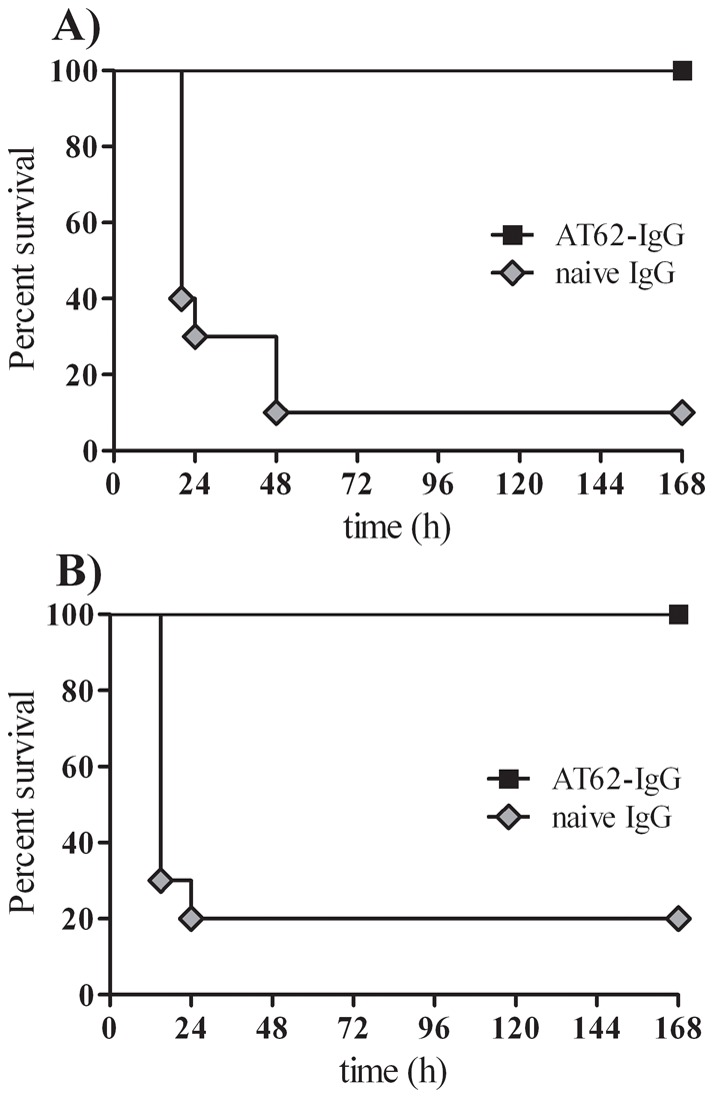
Passive protection with rabbit polyclonal AT-62aa (AT62-IgG) in bacteremia model.Protection from lethal challenge with S. aureus USA300 (A) or USA400 (B) after passive immunization with polyclonal rabbit antibodies AT62-IgG (black square) compared to mock-treated mice (grey diamond). Statistical analysis was performed using Log-Rank (Mantel-Cox) test, P<0.0001.